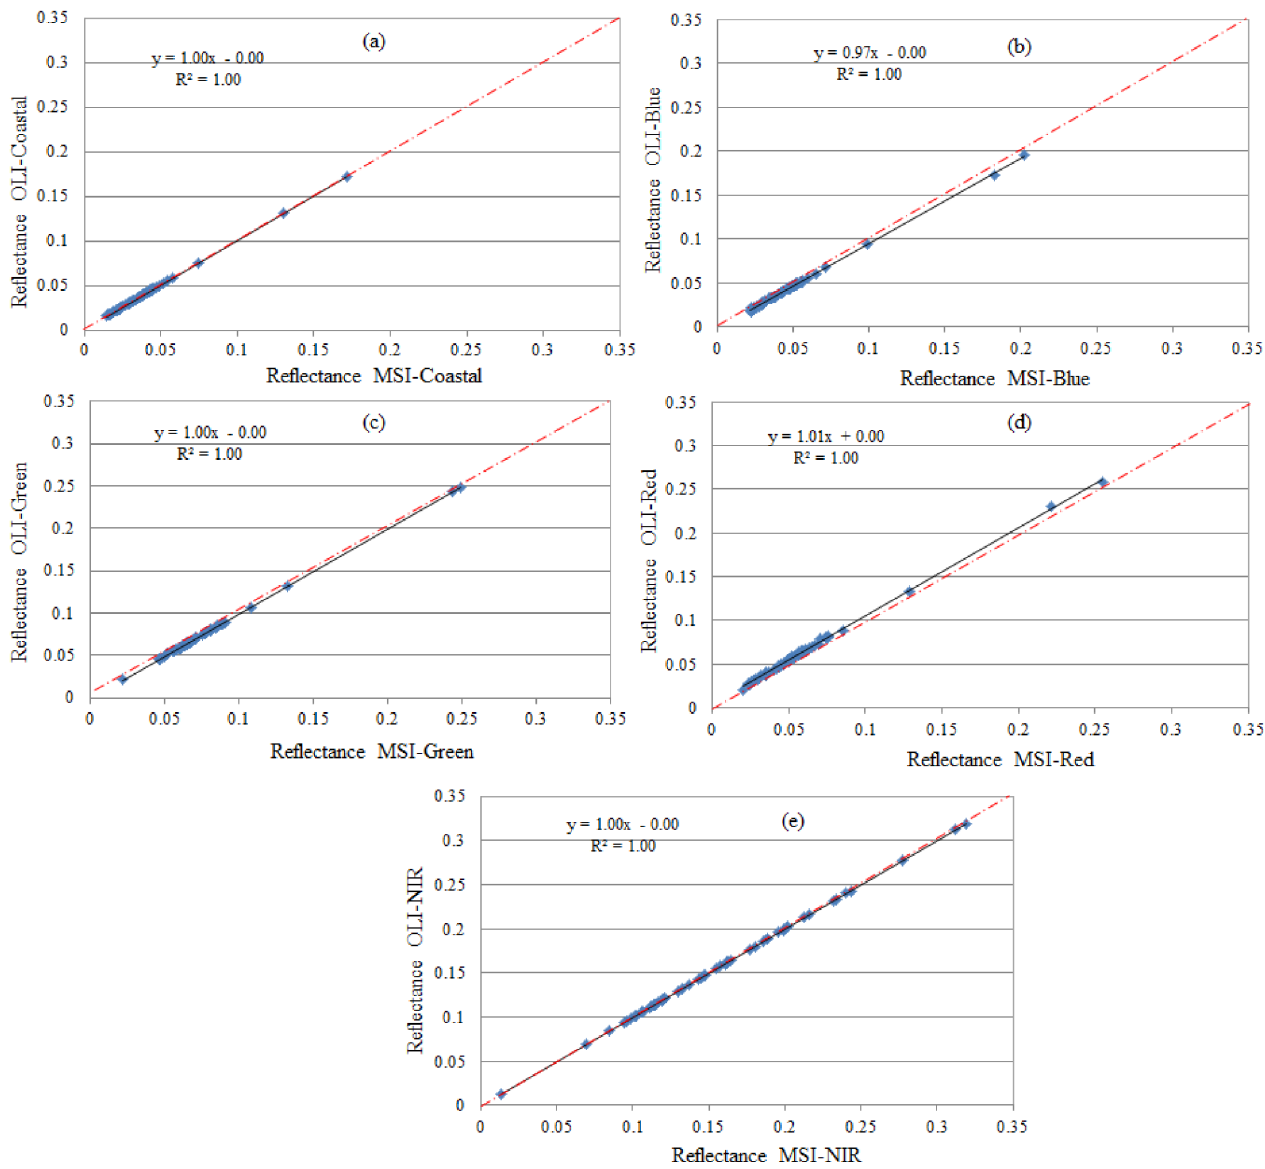
Figure 8. Scatterplots of reflectances sampled and convolved in MSI and OLI homologous spectral